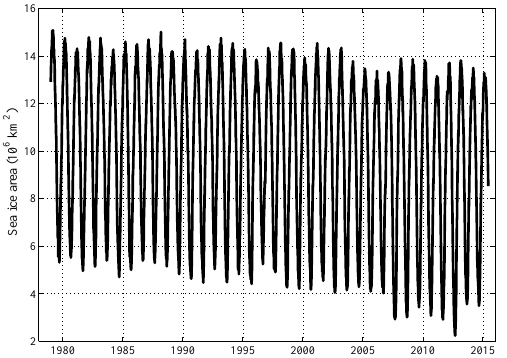
Figure 9. Arctic sea ice area satellite observations from 1979 to present day (2015) obtained from The Cryosphere Today project of the University of